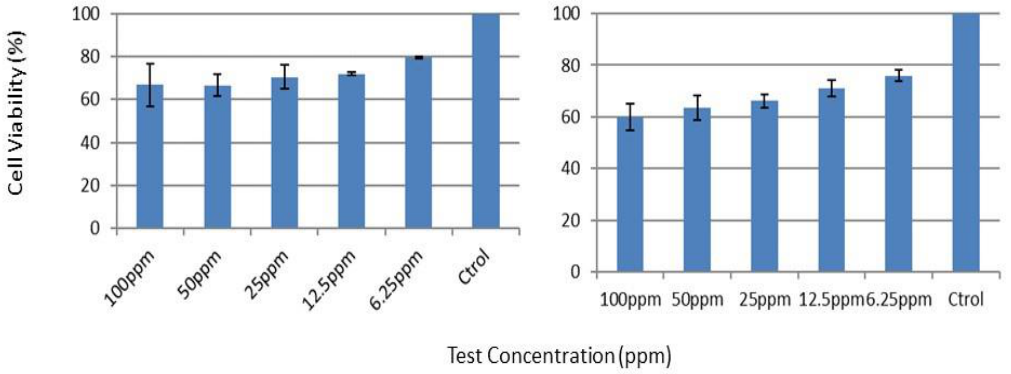
Figure 13. Effect of graphene-related composites on the generation of cytotoxic effects in human skin fibroblast cells: ( Right ) Pristine nanocomposite; ( Left ) graphene-based composite sample (M14, 50% of graphene).